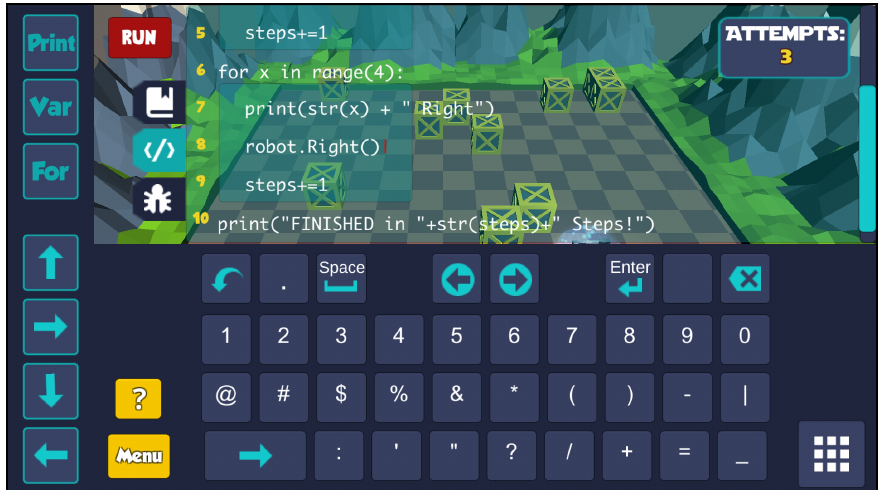
Fig. 3. Players can drag and drop commands to steer the